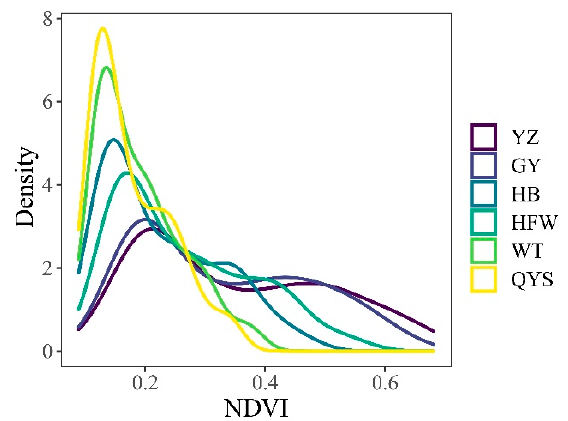
Figure 4. Density curves of the NDVI in the six sub-basins of the QRB from 2006 to 2016.